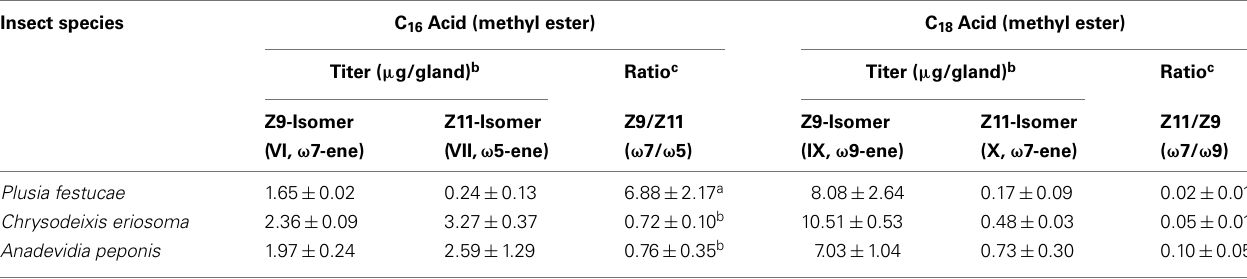
Table 1 | Composition of monounsaturated fatty acids in the pheromone glands of three Plusiinae species a . Insect